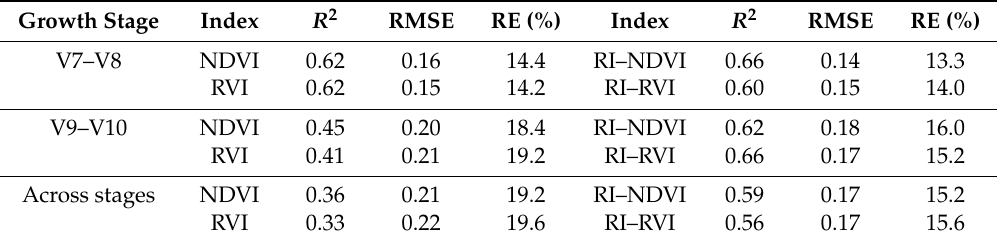
Table 6. Validation results for the estimation of spring maize N nutrition index (NNI) using GreenSeeker sensor-based indices (normalized difference vegetation index (NDVI) and ratio vegetation index (RVI)) and response indices (RI–NDVI and RI–RVI) at different growth stages across 2014 and 2015. Growth Stage